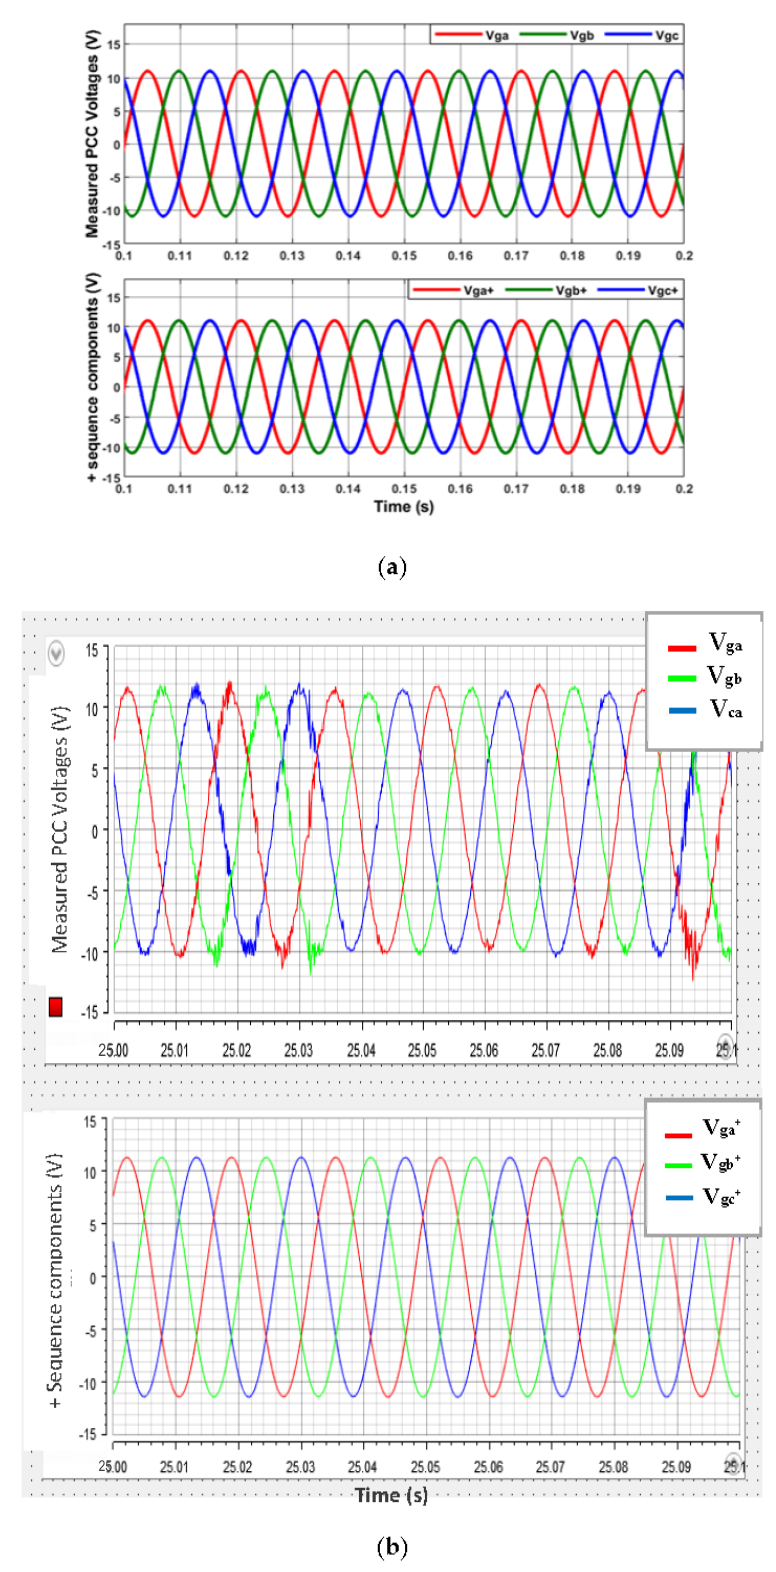
Figure 4. For balanced conditions: ( a ) simulation and ( b ) experimental evaluation of the proposed extraction method where measured point-of-common coupling (PCC) voltages at the top and the positive sequence components of PCC voltages at the bottom.